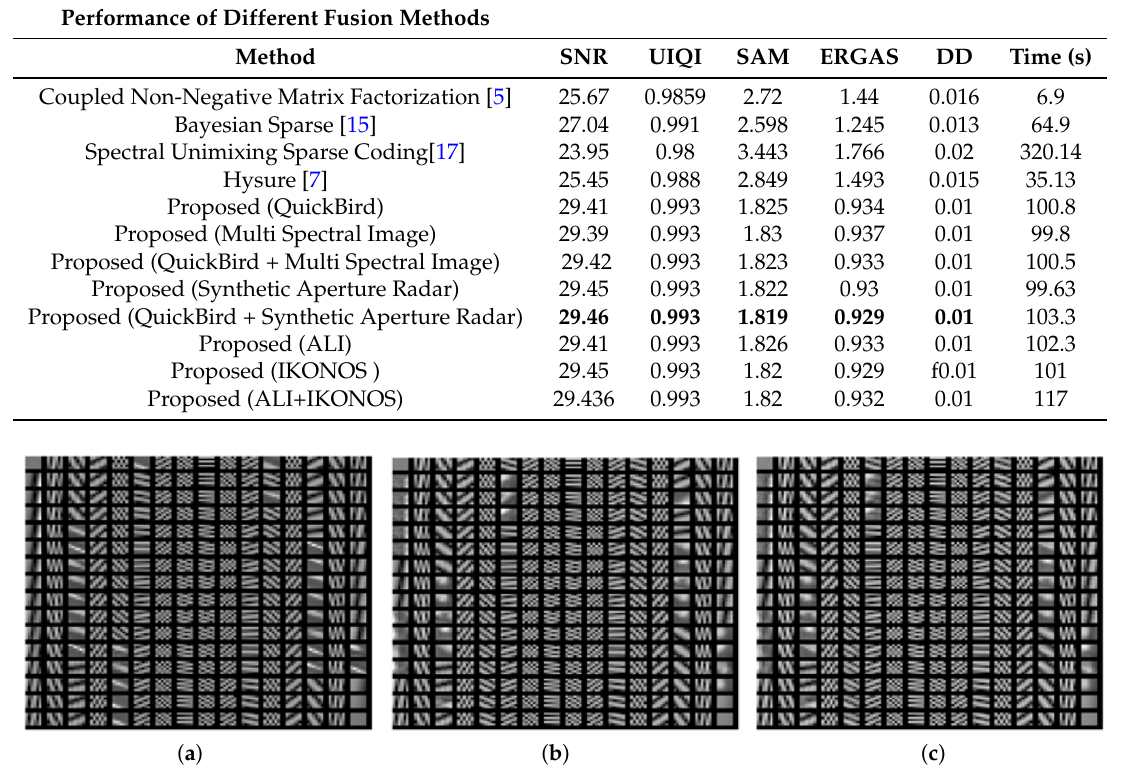
Table 4. Quality measures for the Shiraz dataset (256 × 128 × 170).